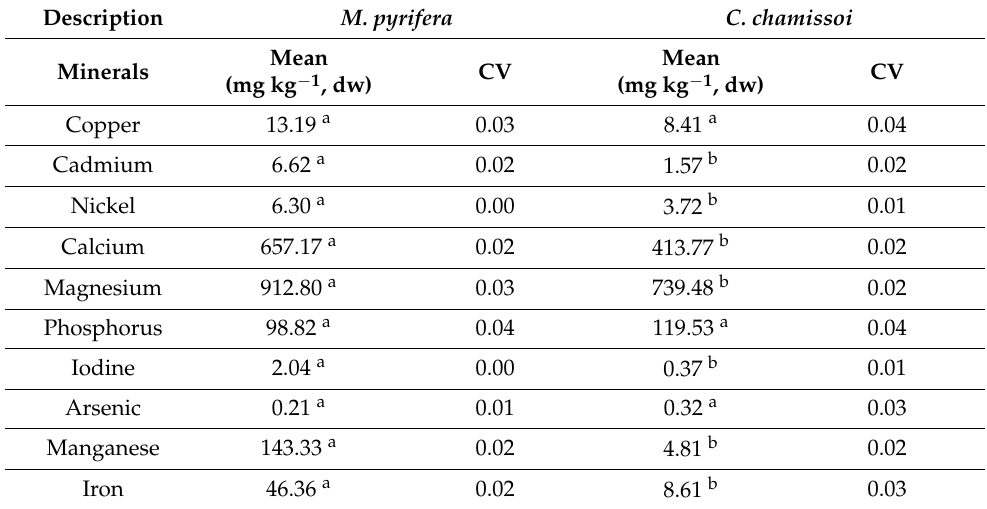
Table 4. Mineral composition of brown ( M. pyrifera ) and red ( C. chamissoi ) Peruvian seaweed.